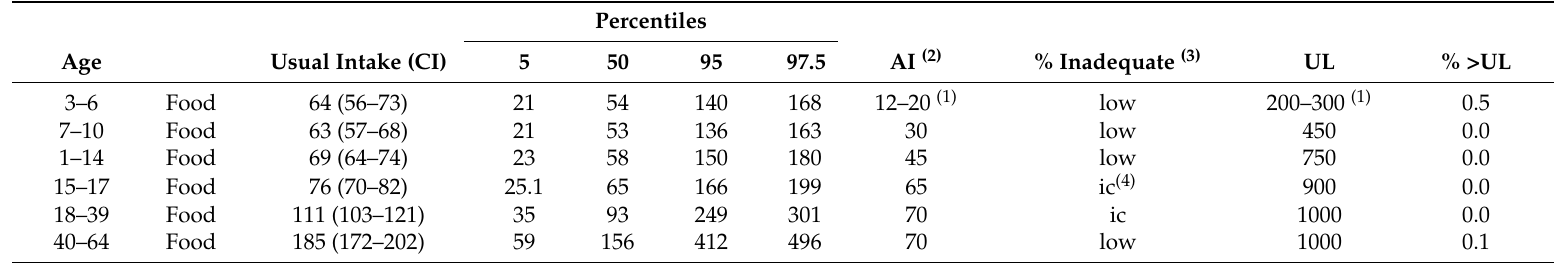
Table 9. Usual intake of vitamin K ( µ g/day) from foods only in Belgian men (3–64 years), Belgian study on the intake of vitamins A, D, E and K (VITADEK-study)